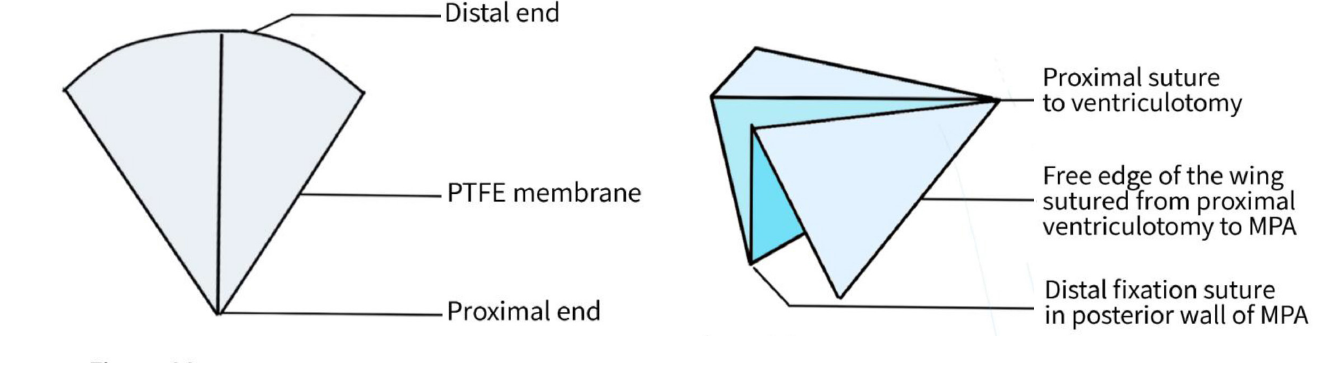
Fig. 1D – Pericardial patch suturing continued proximally on both sides of the main pulmonary artery till pulmonary annulus (points 6 and 7). Pericardial patch (point 8), PFTE membrane (point 5) and infundibulotomy margin (starting from point 5) were sutured in a single layer in a continuous fashion from proximal to distal extent, starting from point 5 to point 6 and then from point 5 to point 7. LPA=left pulmonary artery; PTFE=polytetrafluoroethylene; RPA=right pulmonary artery; RVOT=right ventricular outflow tract